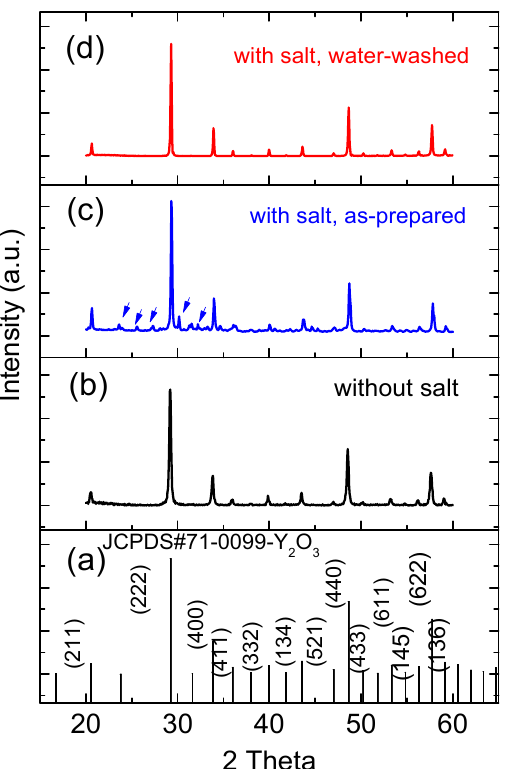
Figure 6. ( a ) JCPDS #71-0099 reference pattern of cubic phase Y 2 O 3 ; XRD patterns of ( b ) as-prepared FSP product without sodium salts; ( c ) as-prepared FSP product with sodium salts; and ( d ) water-washed FSP product with sodium salts.